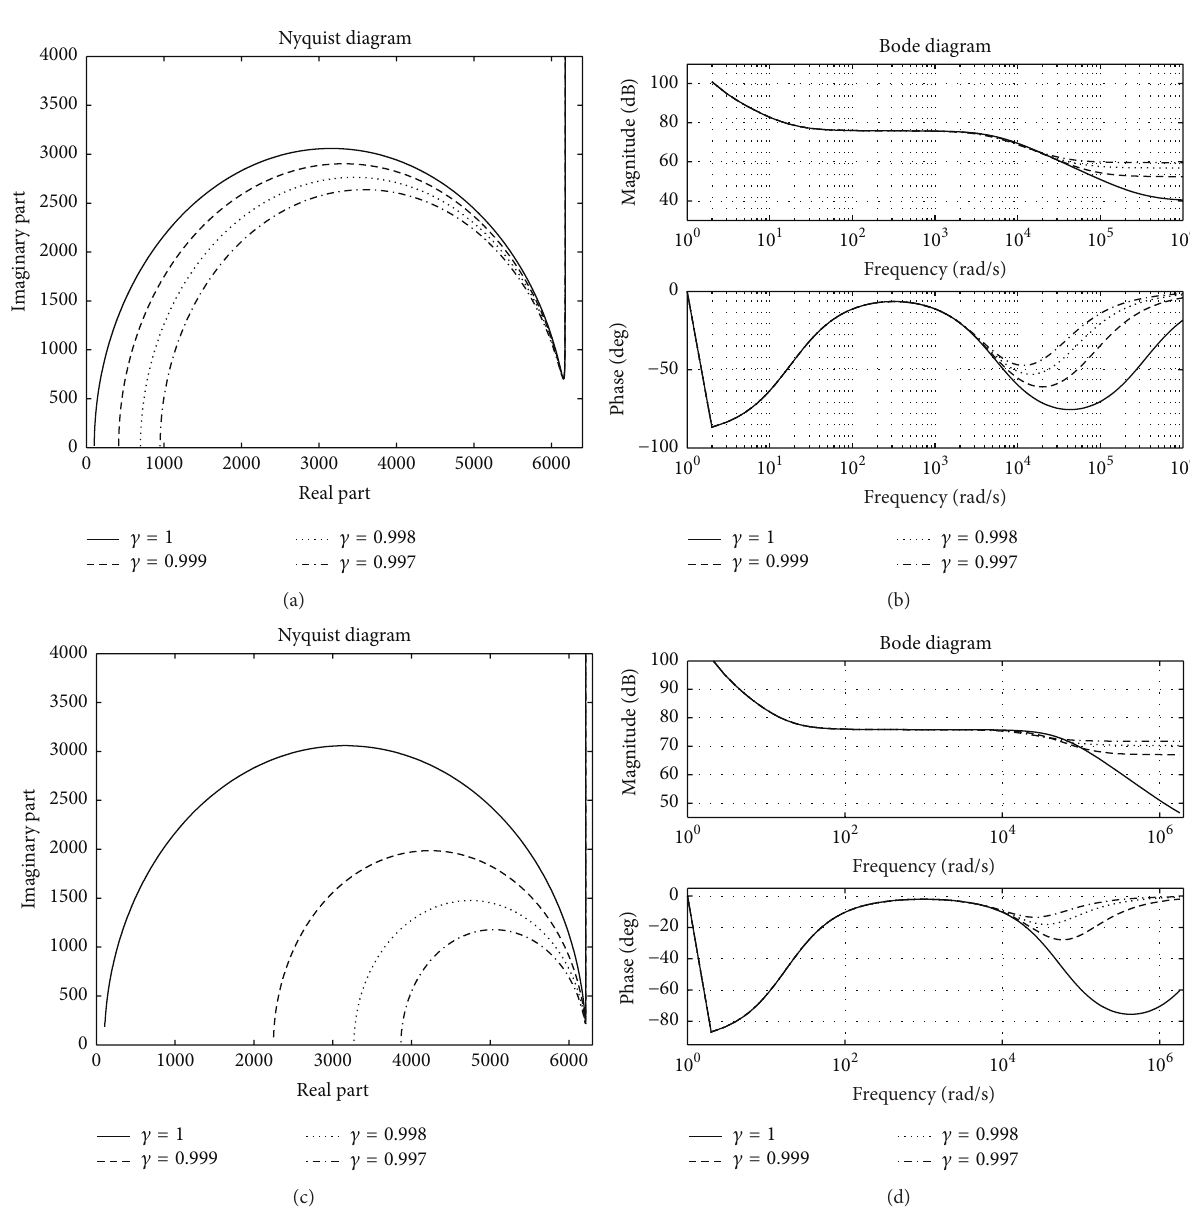
𝛾 = 1 , 𝛾 = 0.95 , 𝛾 = 0.9 , and 𝛾 = 0.85 ; for (c) and (d), 𝑅 𝑠 ,